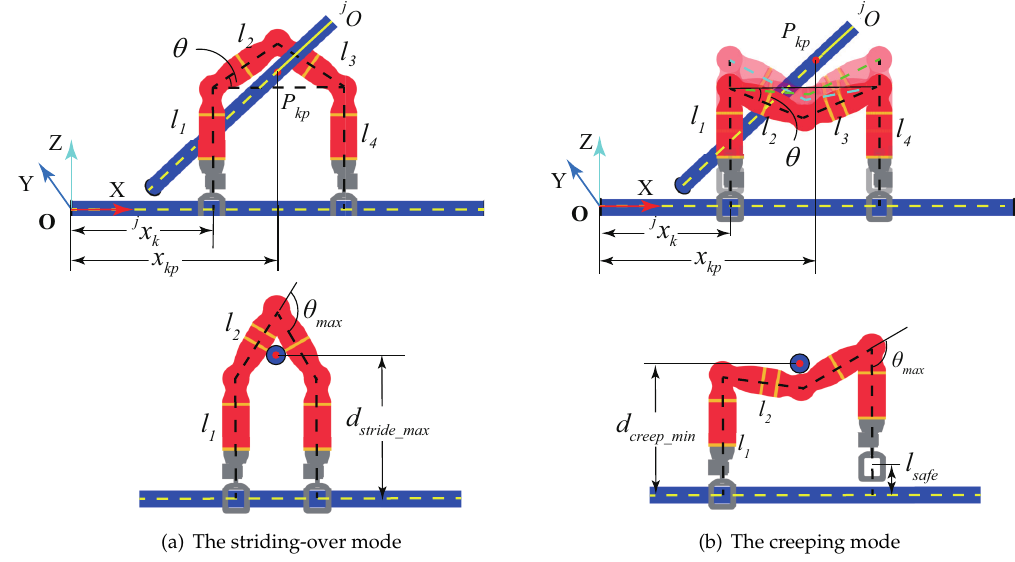
Figure 6. Negotiating obstacles with the striding-over mode and the creeping